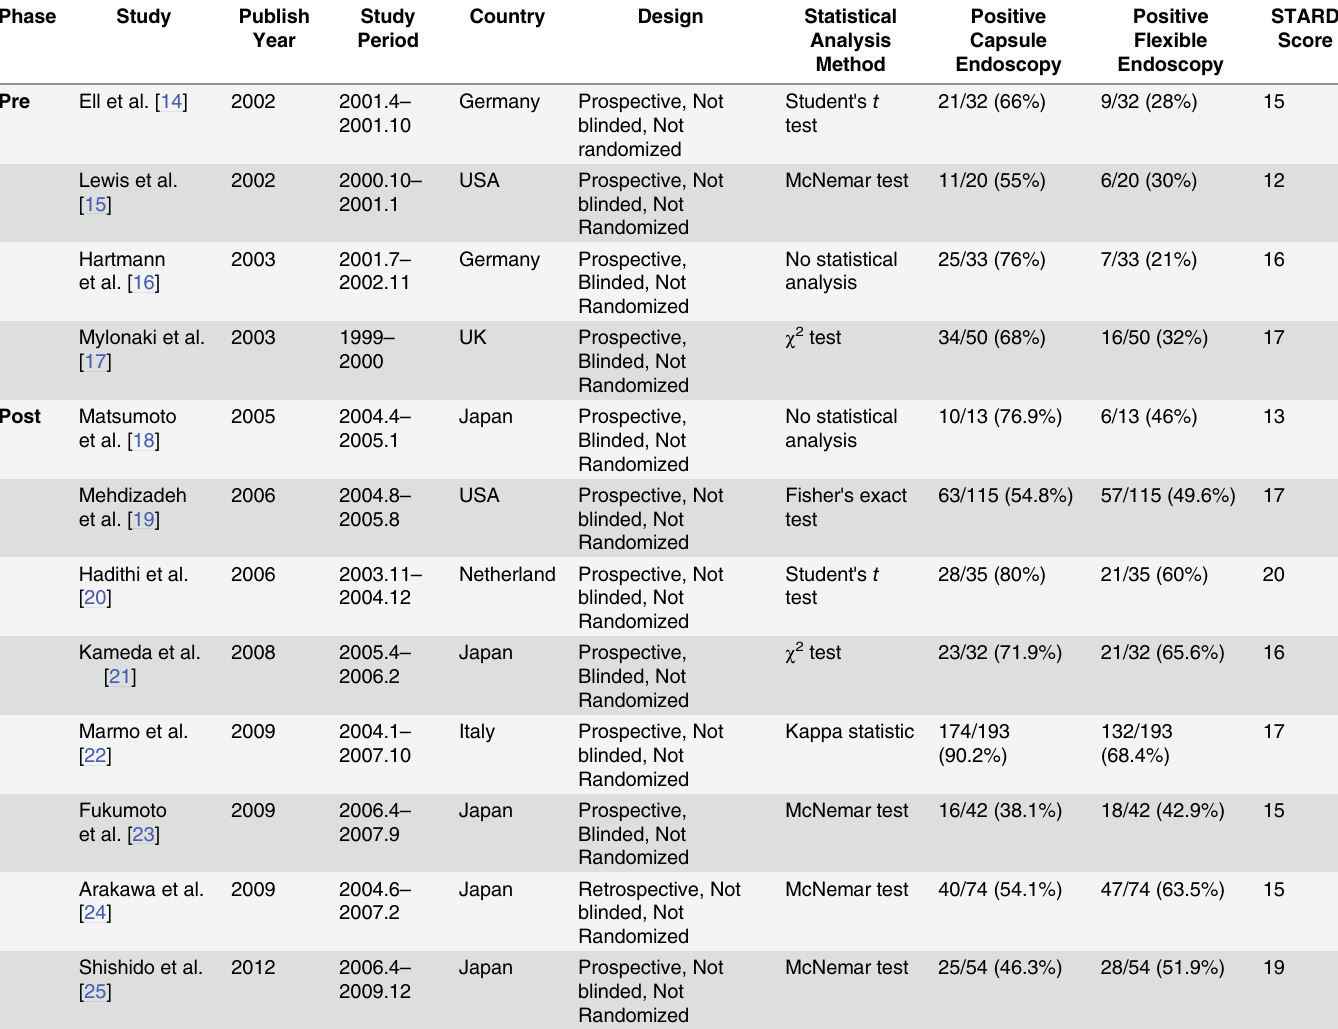
Table 1. Data of the selected studies selected for the